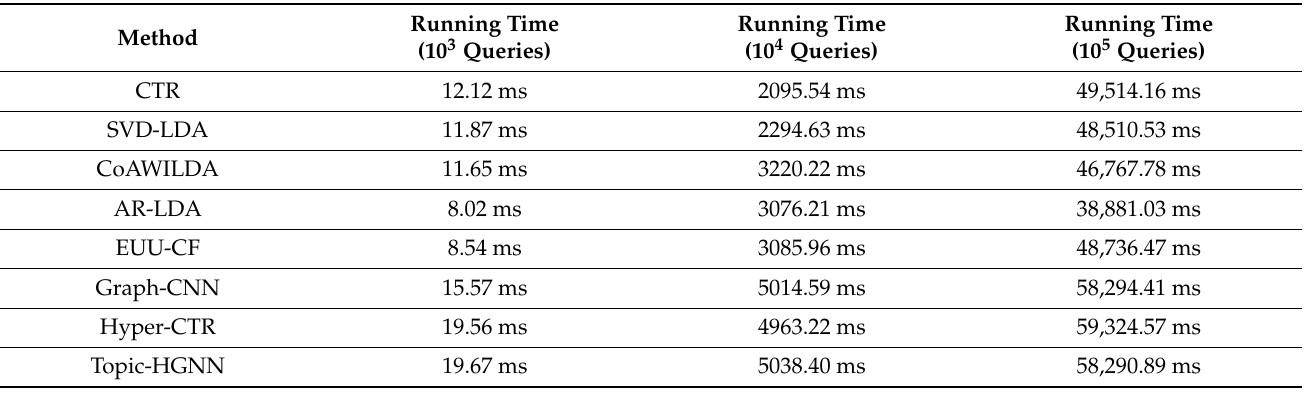
Table 3. The running time of each method under different query search volumes on Retailrock dataset (the number of recommendation results is 10).